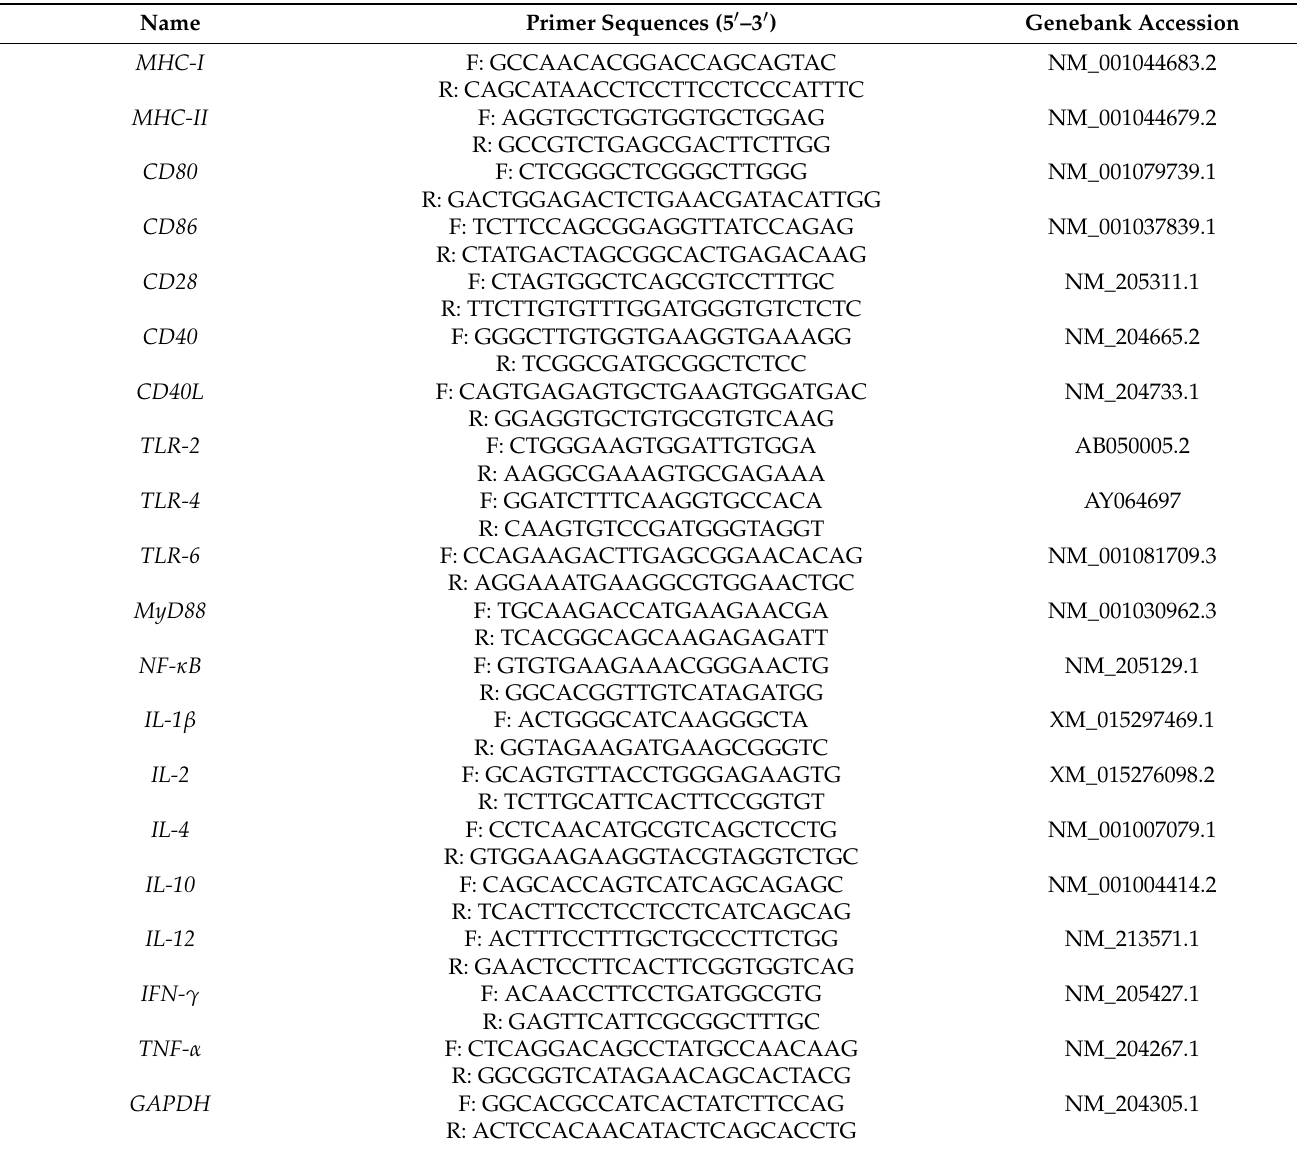
Table A1. Sequences of the oligonucleotide primers used for quantitative real-time PCR a